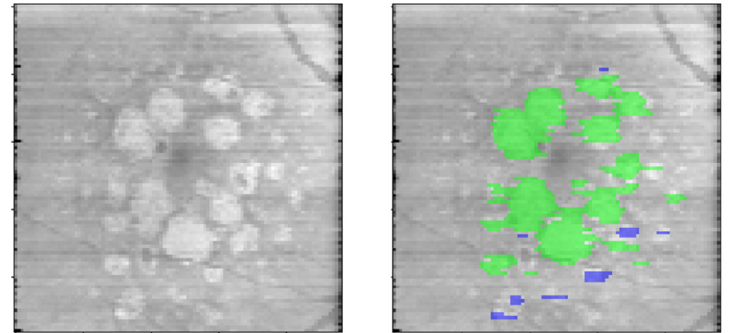
Figure 3. Raw en face OCT image (Left); En face OCT image with cRORA ground truth mask overlay (shown in green) and GA lesions that did not meet the 250-micron size threshold (shown in blue). OCT: optical coherence tomography; cRORA: complete RPE and outer retinal atrophy; RPE: retinal pigment epithelium. Images were captured using Heidelberg Spectralis HRA+OCT (Heidelberg Engineering, Heidelberg, Germany) with the 97 B-scan macular cube protocol.